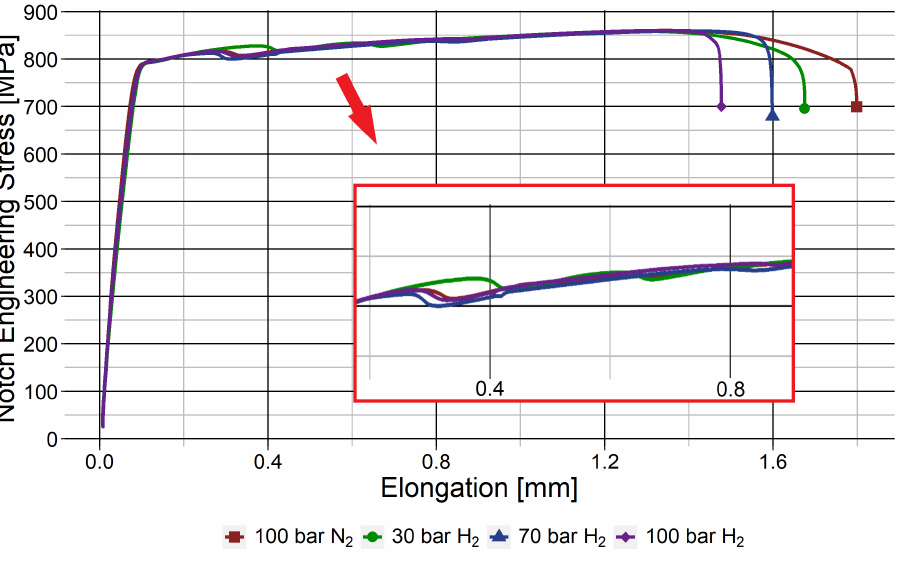
Figure 8. SSRT results from representative samples of each subset of notched weld metal